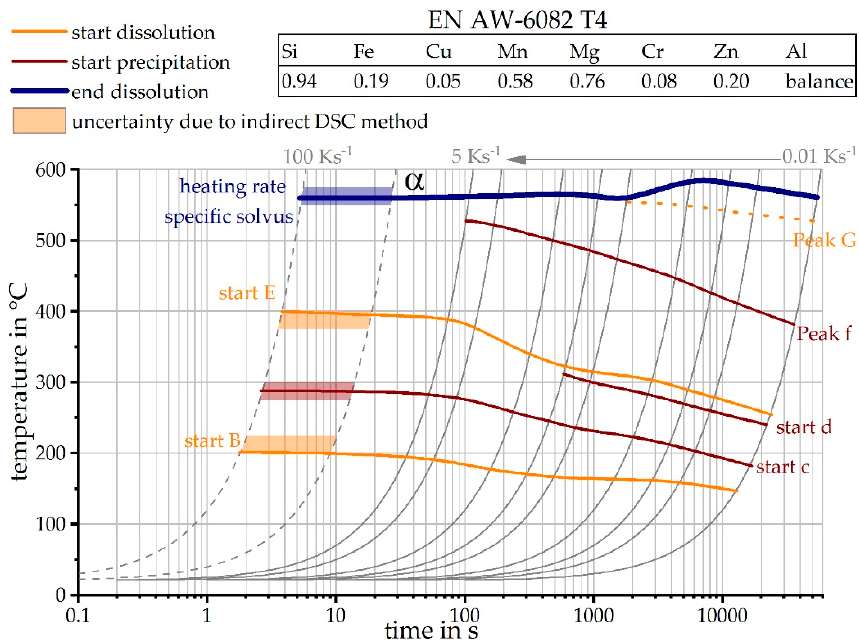
Figure 13. Continuous heating dissolution diagram of EN AW-6082 T4, including the findings of the indirect measurements.